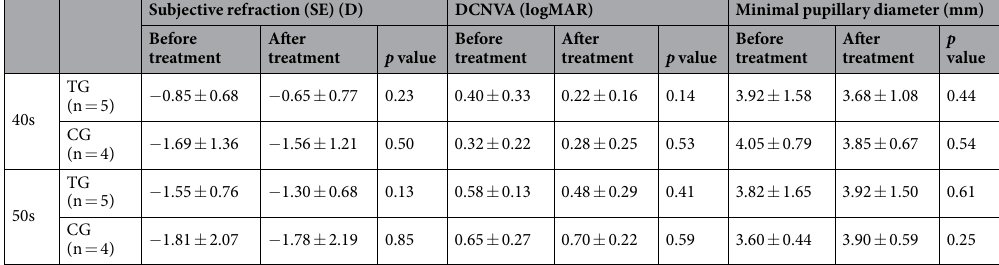
Table 3. Changes in the SE of the objective refraction, DCNVA, and minimal pupillary diameter. The data are expressed as the mean ± the standard deviation. SE = spherical equivalent; D = diopters; logMAR = logarithm of the minimum angle of resolution; DCNVA = distance corrected near visual acuity; TG = treatment group; CG = control group; 40s = fifth decade of life; 50s = sixth decade of life.